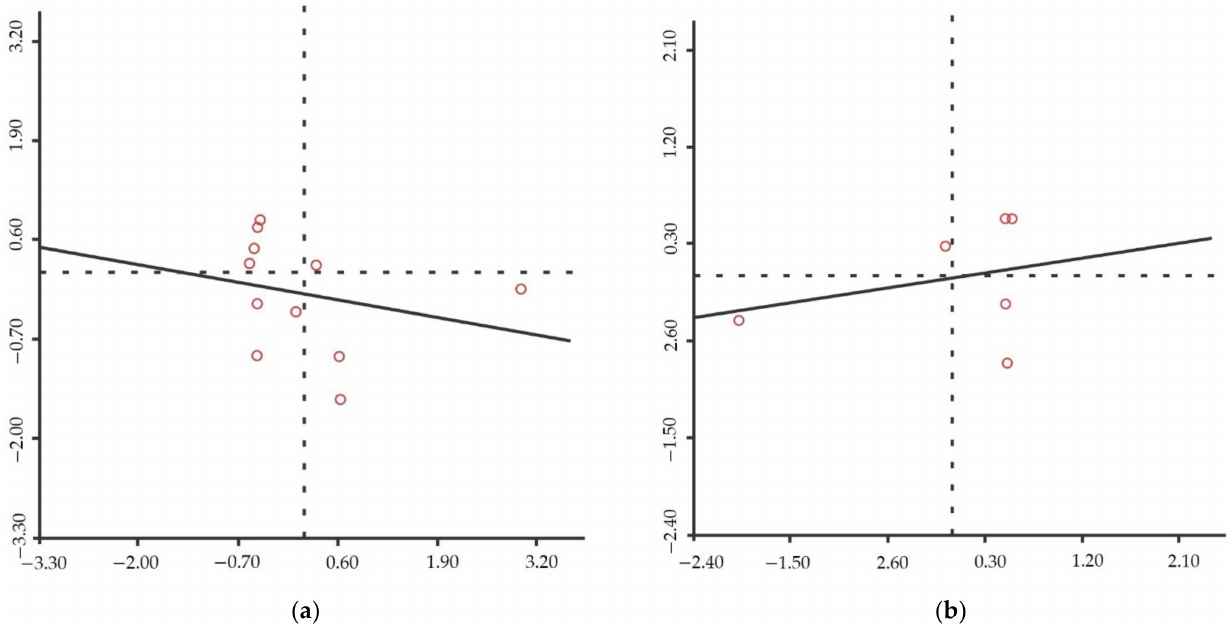
Figure 12. Scatter plots of the Local Moran’s Index: ( a ) scatter spot of Local Moran’s Index in the eastern regions; ( b ) scatter spot of Local Moran’s Index in the western